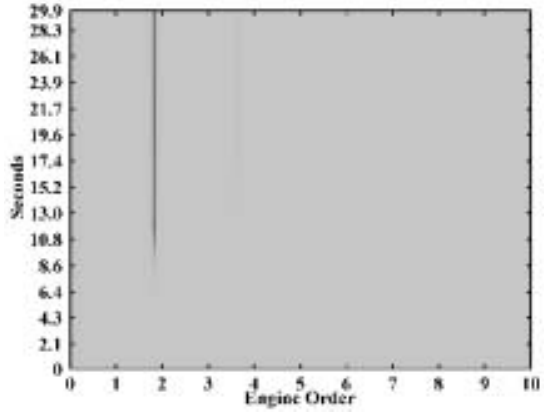
Fig. 10. Top down view of Fig. 9. The peak response occurs at 1 . 82 engine